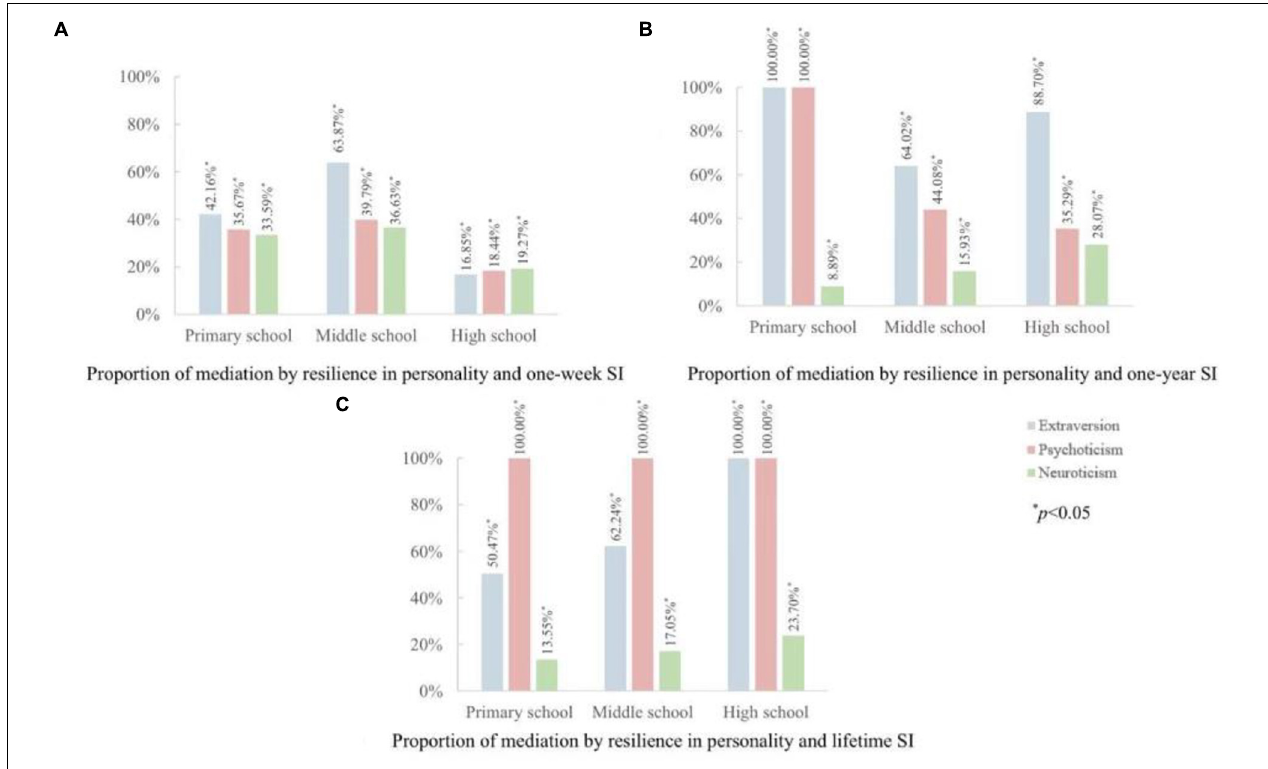
FIGURE 2 | Proportions of mediation by resilience in the associations between personality traits and SI for different types of students. (A) One-week SI; (B) One-year SI; (C) Lifetime SI.